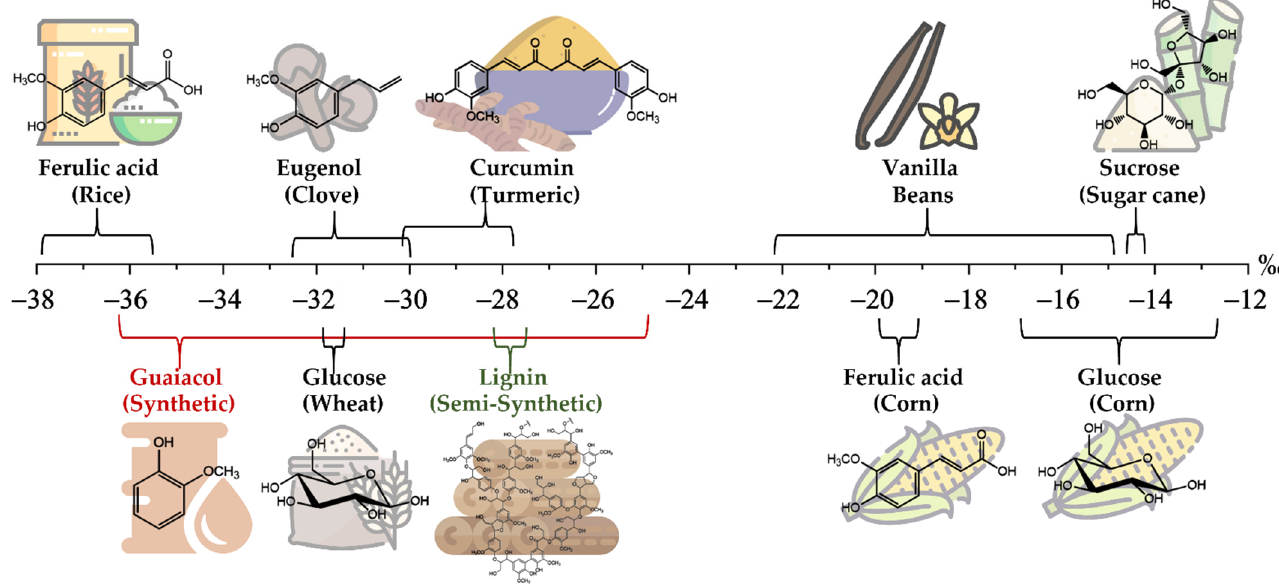
Figure 2. δ 13 C range of values for vanillin according to a specific source and chemical used as precursor.